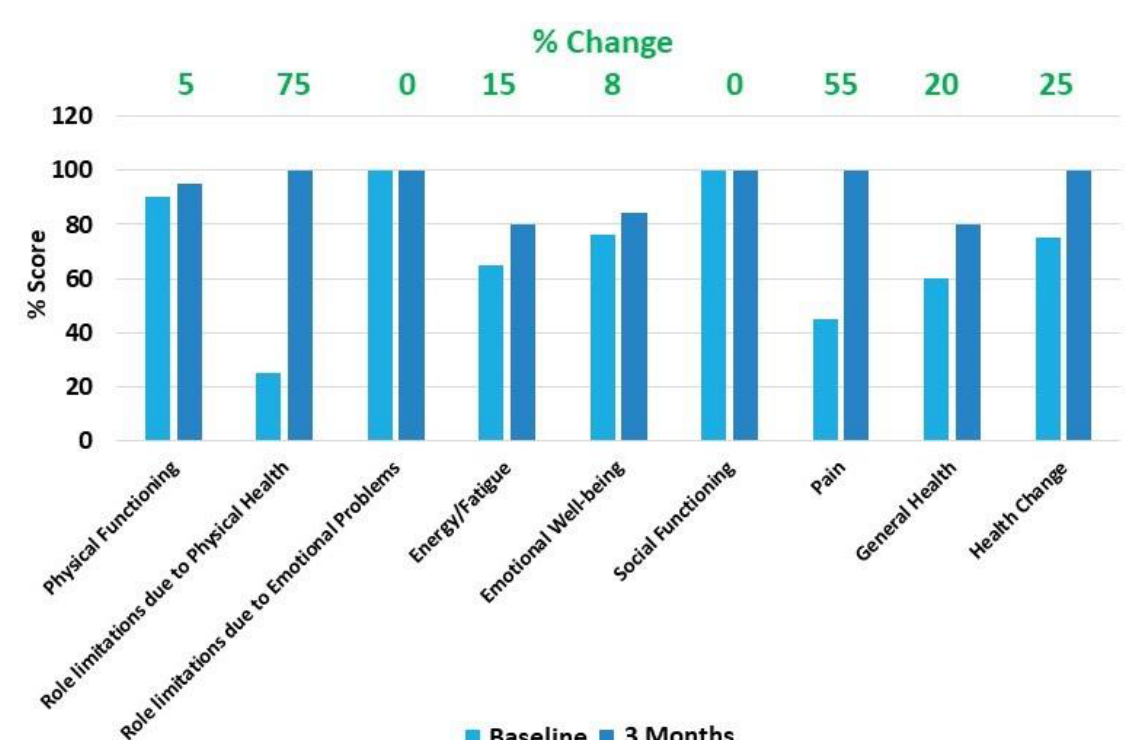
Figure 5. 36-Item Short Form Survey (SF-36). SF-36 showed 25% improvement in overall Health change at 3 months follow-up compared to baseline. The individual SF-36 subscales analysis showed improvements in Physical Functioning (5%), Role limitations due to Physical Health (75%), Energy/Fatigue (15%), Emotional Well-being (8%), Pain (55%), and General Health (20%) at 3 months follow-up compared to baseline. The patient did not report any concerns with SF-36 subscales of Role limitation due to Emotional Problems and Social Functioning at baseline.